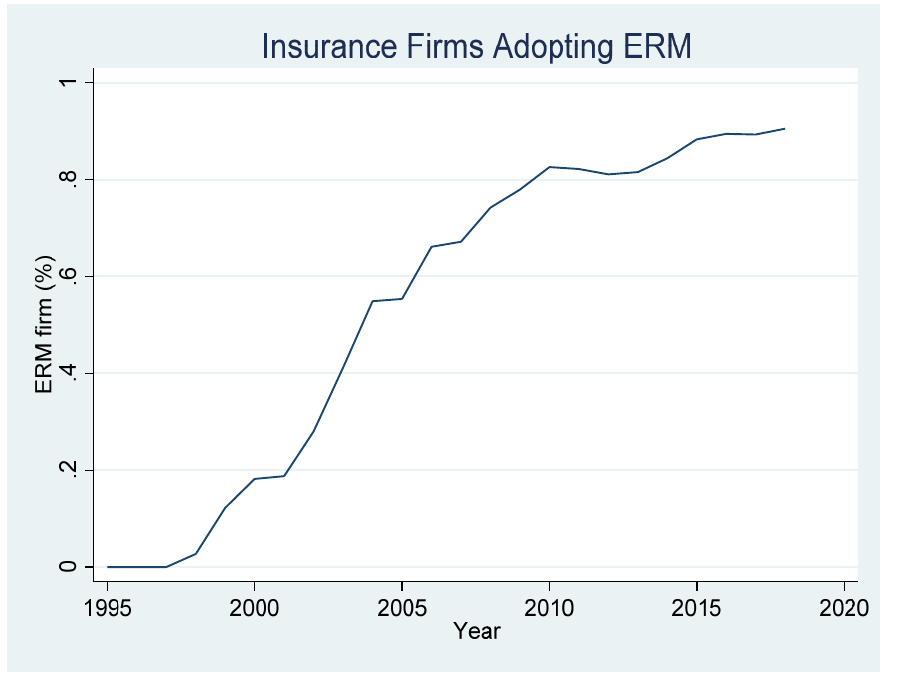
Figure 1. ERM adopting firms. Table 1. Variable